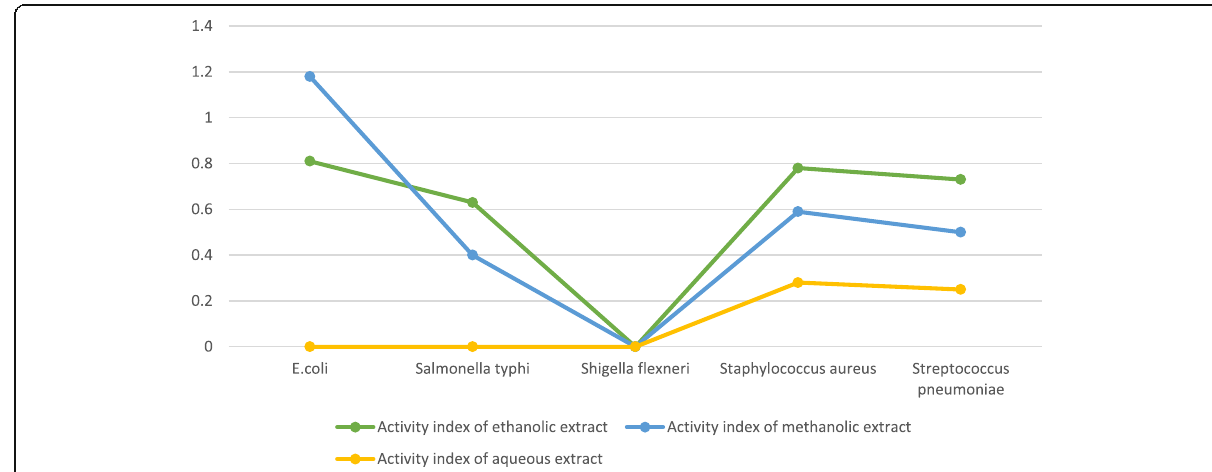
Fig. 6 Activity index of ethanolic, methanolic, and aqueous extracts against different microorganism. E. coli had the highest activity index in the ethanolic extract (value 0.81) as well as in the methanolic extract (value 1.18), while the lowest was seen for Shigella flexneri (value 0 in all